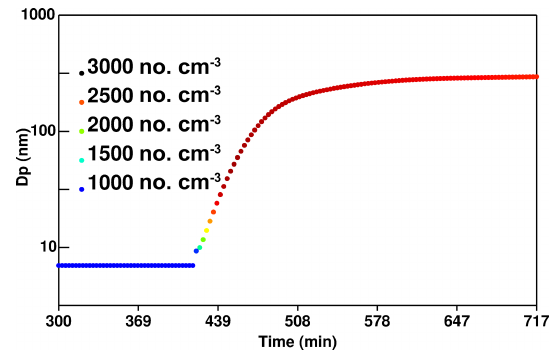
Figure 1. Simulated particle nucleation event followed by growth due to SOA condensation under conditions representing July in Cal- ifornia. The vertical axis displays the mean diameter of the nuclei mode, while color represents the particle number